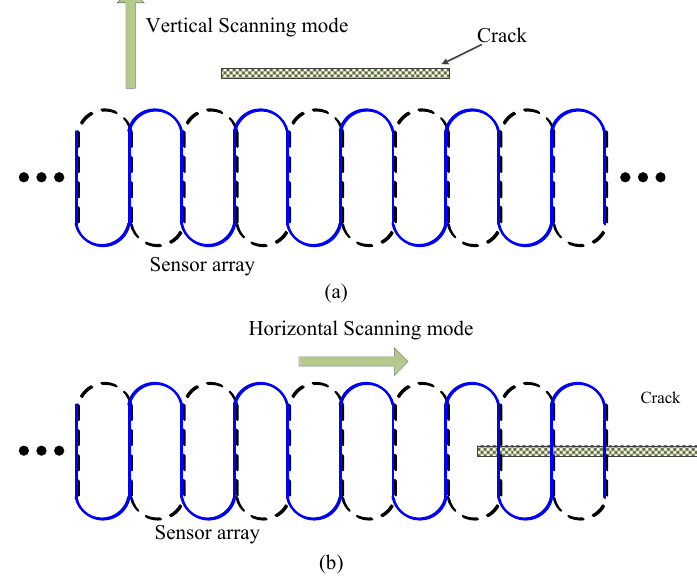
Figure 3. Two scanning modes: ( a ) V mode; ( b ) H mode.